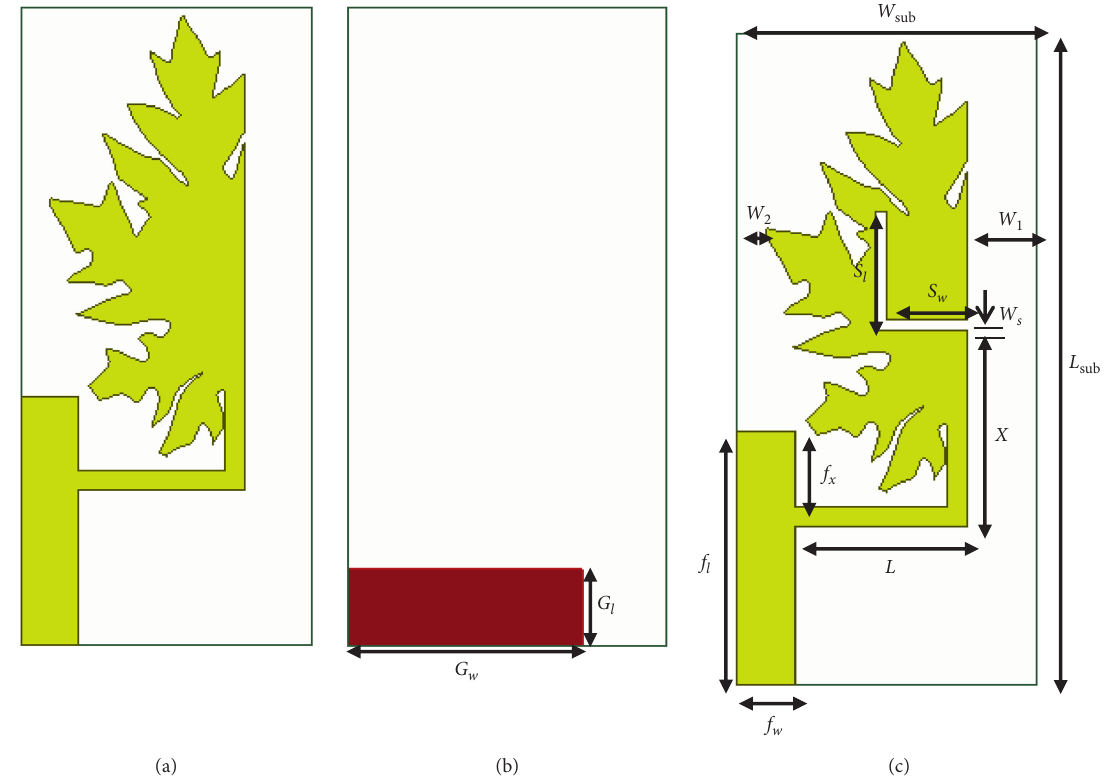
Figure 2: Top-view of the proposed Vine-leaf based configurations. (a) Slitless patch. (b) Defected-width ground plane, (c) L-slitted patch